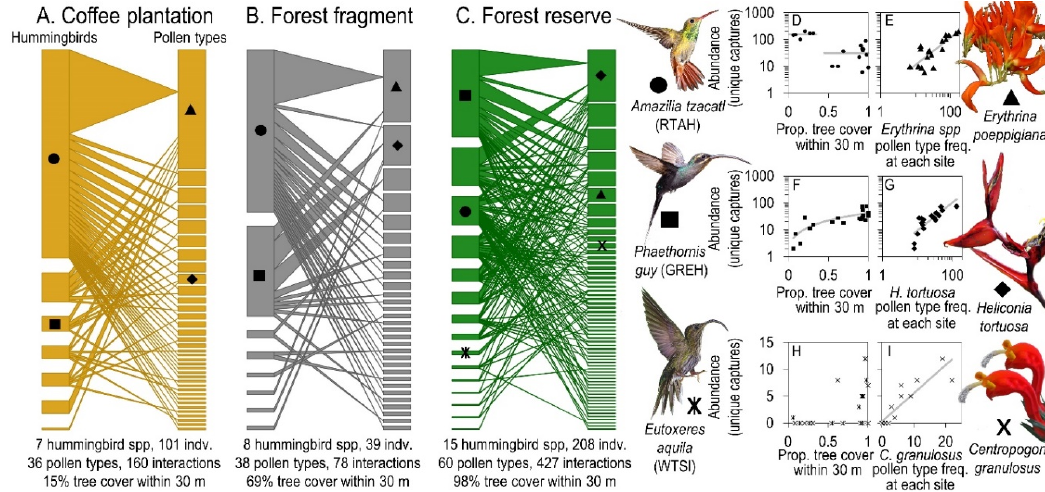
Figure 3. Representative hummingbird–pollen type networks from sites in a co ff ee plantation ( A ), forest fragment ( B ), and forest reserve ( C ). Boxes on the left are hummingbird species; boxes on the right are pollen types. Height of the boxes represents relative abundance of hummingbirds and frequencies of pollen type in each network. Width of the connecting lines represents the number of times an interaction between a hummingbird species and a pollen type was observed. Symbols for each hummingbird and pollen type indicate their locations in the representative networks. Networks from sites located in co ff ee plantations were dominated by A. tzacatl ( D ). A. tzacatl interacted with 150 pollen types and mostly with Erythrina spp., whose frequency at each site was correlated with the abundance of A. tzacatl, meaning that as catches of A. tzacatl increased, so too did the number of observations of Erythrina spp., indicating frequent interactions between the two. ( E ). Networks from sites located in forest sites were dominated by P. guy , a hummingbird whose abundance increases proportionally with increasing tree cover within 30 m of mist nets at each site ( F ). P. guy interacted with 64 pollen types and mostly with Heliconia tortuosa , whose frequency at each site was correlated with the abundance of P. guy ( G ). Hummingbirds that tended to be more forest dependent also tended to be more specialized, especially E. aquila , whose rare observations were mostly in forest sites ( H ). E. aquila interacted with 11 pollen types and mostly with C. granulosus , whose frequency at each site was correlated with the abundance of E. aquila ( I ). All trend lines in subfigures ( D – G and I ) represent best fit models with a p -value ≤